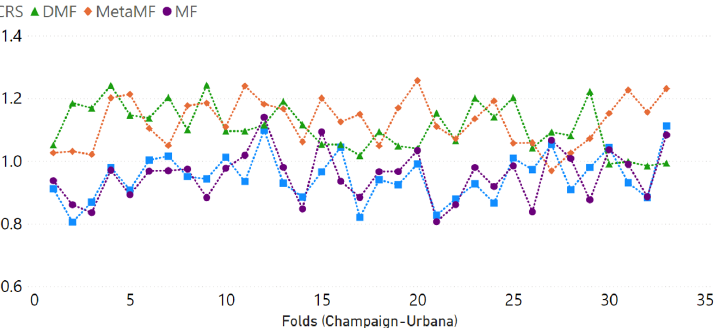
Figure 6. The MAE comparisons among the four models for each training–test dataset pair (Champaign-Urbana). The dataset is partitioned chronologically. (Abscissa: value of MAE; Or- dinate: index of folds).